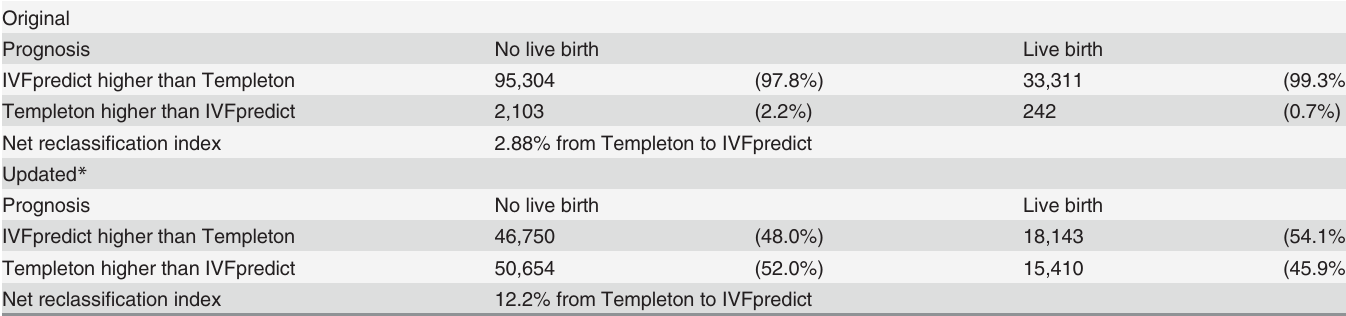
Table 5. Net reclassification index for IVFpredict compared with the Templeton